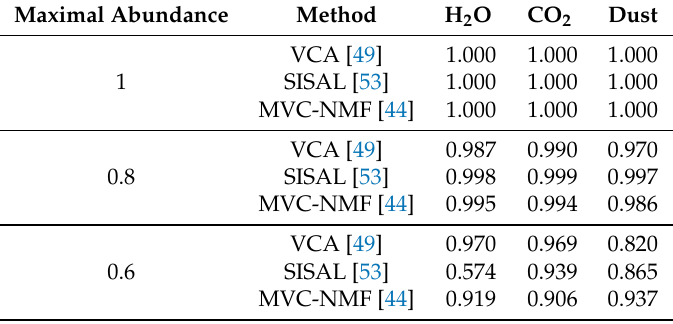
Table 3. Correlation coefficients (CC) and spectral angles (SA) between the reference spectra and the spectra of the endmembers extracted by VCA, SISAL and MVC-NMF when the maximal abundances of the endmembers range from